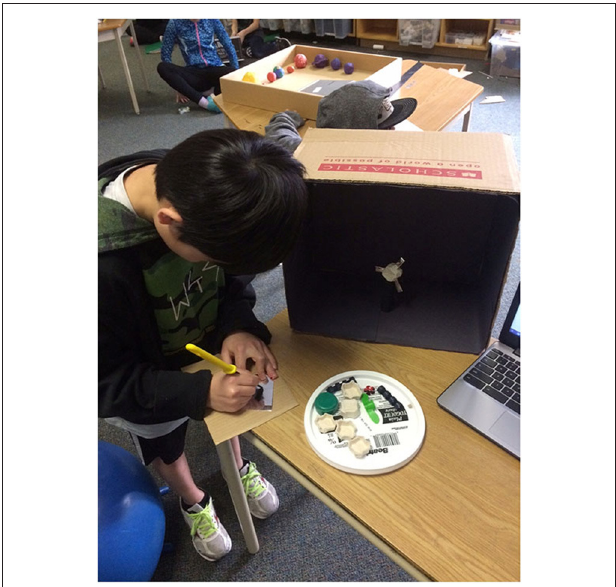
FIGURE 2 | Student making a model of the Juno satellite, with materials for consideration at hand ( Becker,